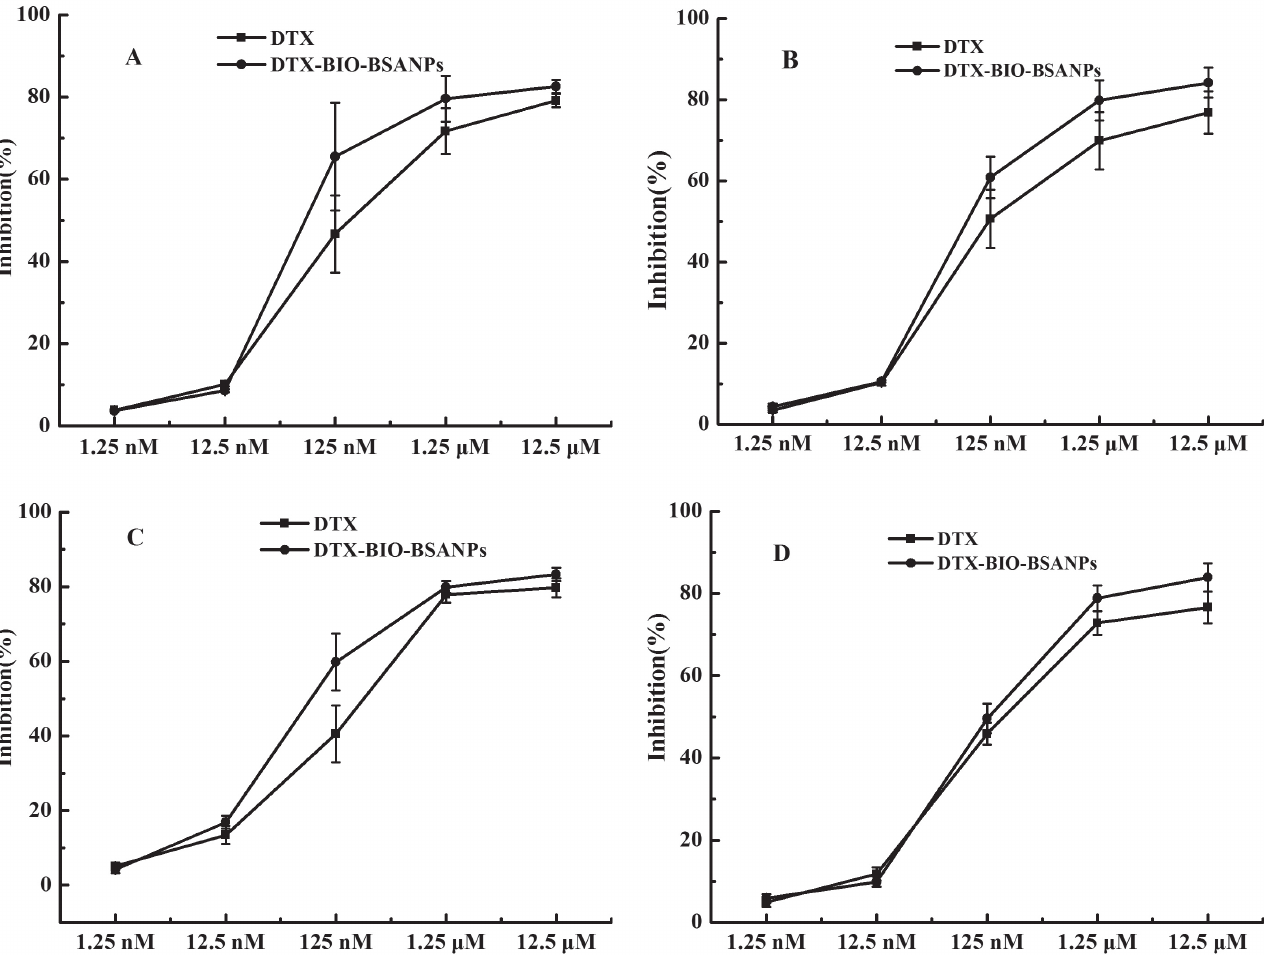
FIGURE 6 - DTX-BIO-BSA-NPs and docetaxel induces growth inhibition. The MCF-7 (A), SGC7901 cells (B), LS-174T cells (C) and A549 cells (D) were exposed to DTX-BIO-BSA-NPs (●) and docetaxel (■) at concentrations ranging from 1.25 nM-12.5 μM and incubated for 48 h. The inhibitory ratio was measured by MTT assay. Data are represented as means ± SD of three independent experiments with six replicates